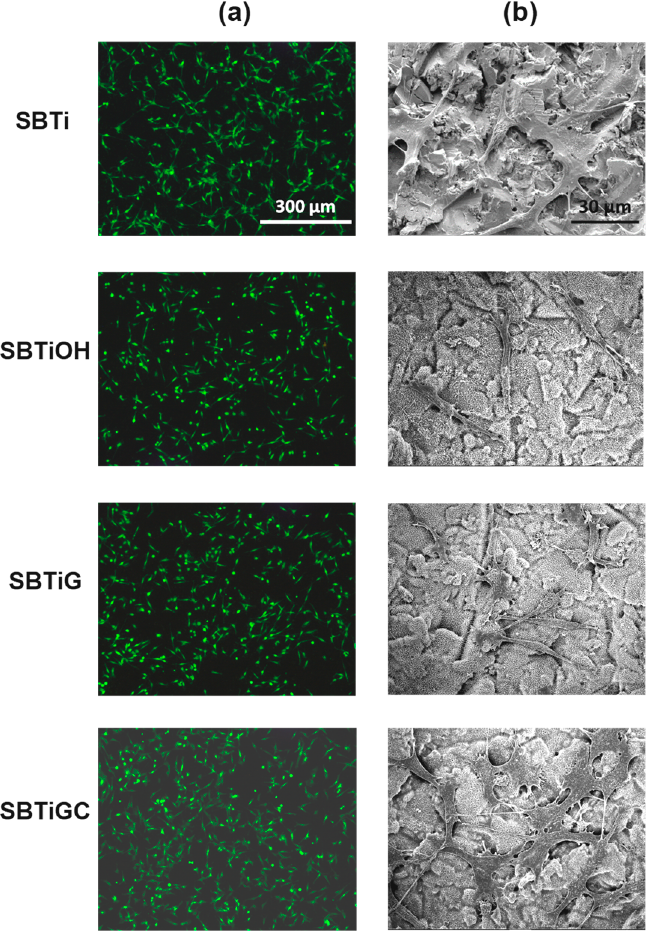
Figure 4. ( a ) Fluorescence microscopy images and ( b ) FE-SEM micrographs indicating cell adhesion of GFP-labeled hMSCs on test samples following an incubation period of 24 h.